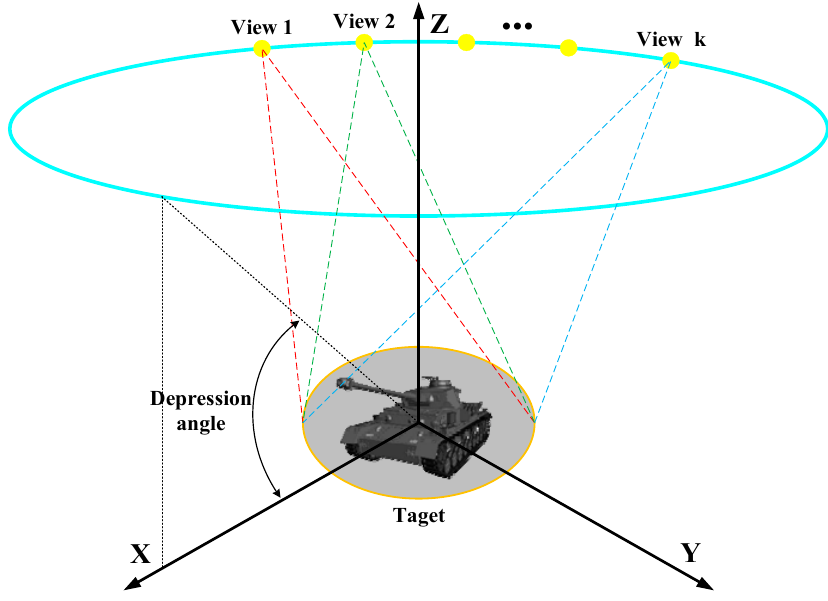
Figure 3. Illustration of multi-view SAR image acquisition.